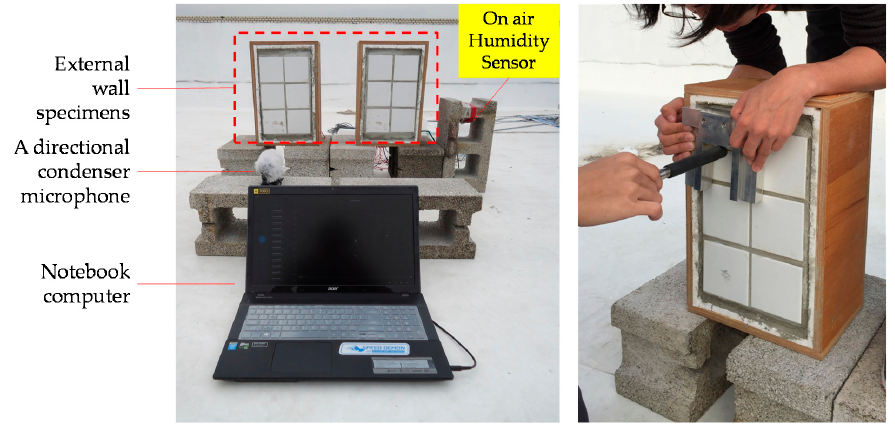
Figure 4. Experiment device ( left ) and tapping method ( right ).